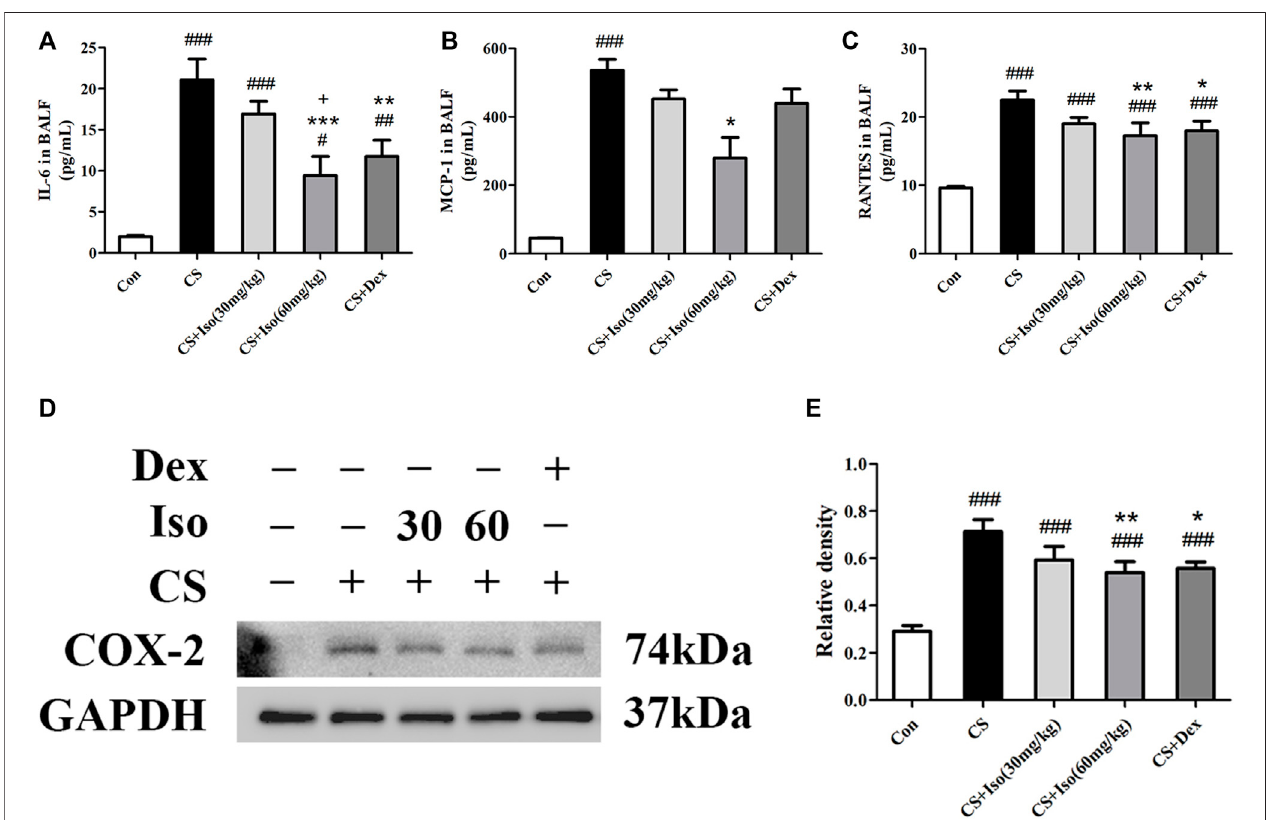
FIGURE 7 | Iso reduces the excessive expression of proin fl ammatory cytokines induced by CS. (A – C) The levels of IL-6, MCP-1 and RANTES in BALF were measured ( n = 5 mice per group). (D) The protein expression level of COX-2 in lung tissues was analyzed using Western blotting ( n = 3 mice per group). (E) The band intensityofCOX-2wassemiquanti fi edusingImageJ.GAPDHwasusedastheinternalreference.Datawasshownasmean(±SD) (A – C – E) .Totestforgroupdifferencses one-wayANOVA (A – C – E) wasapplied. # p < 0.05, ## p < 0.01, ### p < 0.001vs.controlgroup,* p < 0.05,** p < 0.01,*** p < 0.001vs.CSgroupand + p < 0.05vs.CS + Iso 30 mg/kg